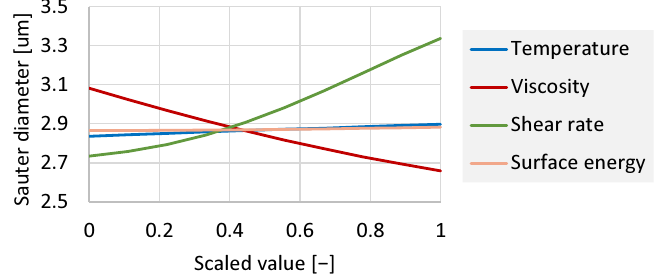
Figure 11. Influence of the ANN model input parameters on the particle growth. All parameters change in rages as defined in Table1 with 0 and 1 corresponding to their min and max values,